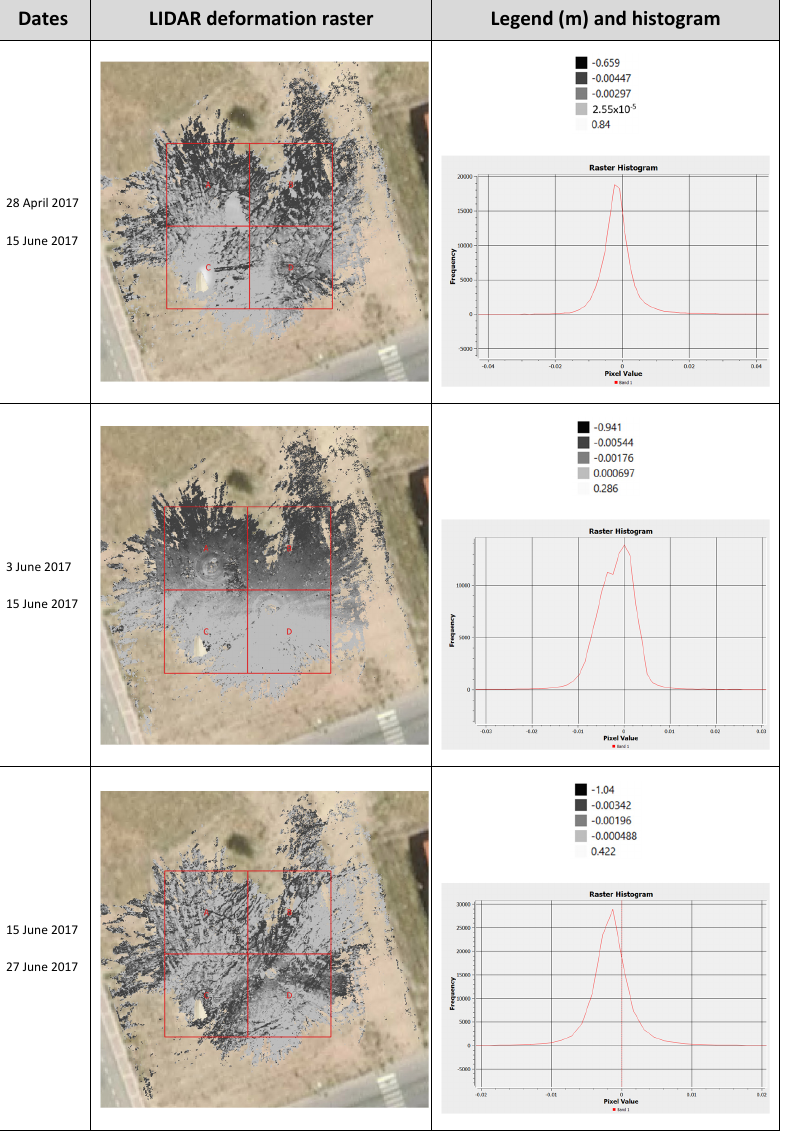
Figure 9. Examples of deformation measurements by LIDAR Clouds comparison WITH A, B, C and D are indicated the equivalent TopSAR cells.